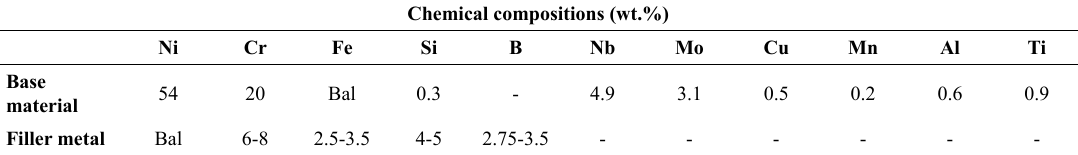
Table 1. Elements constituent of base material and filler metal (wt.%)